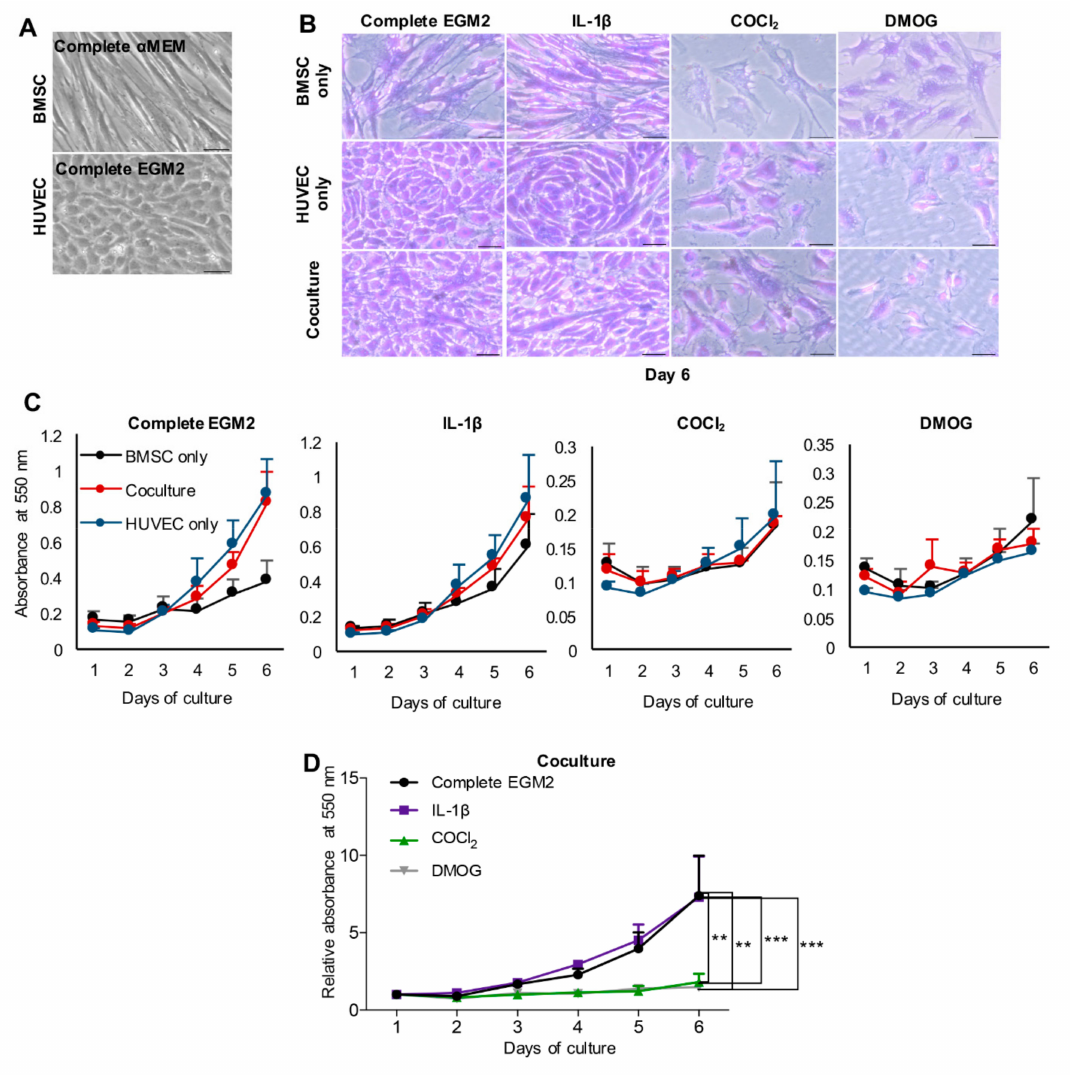
Figure 1. Cell proliferation. ( A ) Morphology of bone marrow-derived mesenchymal stem cells (BMSC) and human umbilical vein endothelial cells (HUVEC) cultured in media Complete α MEM and Complete EGM2, respectively, for cell expansion. ( B ) Morphology of cells in monoculture and coculture in Complete EGM2 medium in the presence / absence of IL-1 β or COCl 2 or DMOG, scale bar 50 µ m. ( C ) Proliferation curve of the cells cultured in Complete EGM2 medium supplemented with IL-1 β or COCl 2 or DMOG determined by measuring the absorbance of the cells stained with crystal violet at 550 nm wavelength. ( D ) Relative proliferation of cocultured cells in di ff erent media over time compared to day 1. Results are the average + SEM of three experiments performed in quintuplicate from three di ff erent cell cultures. Lower chart demonstrates relative proliferation of cocultured cells over time normalized to day 1 ( ∗∗ p ≤ 0.0018, ∗∗∗ p ≤